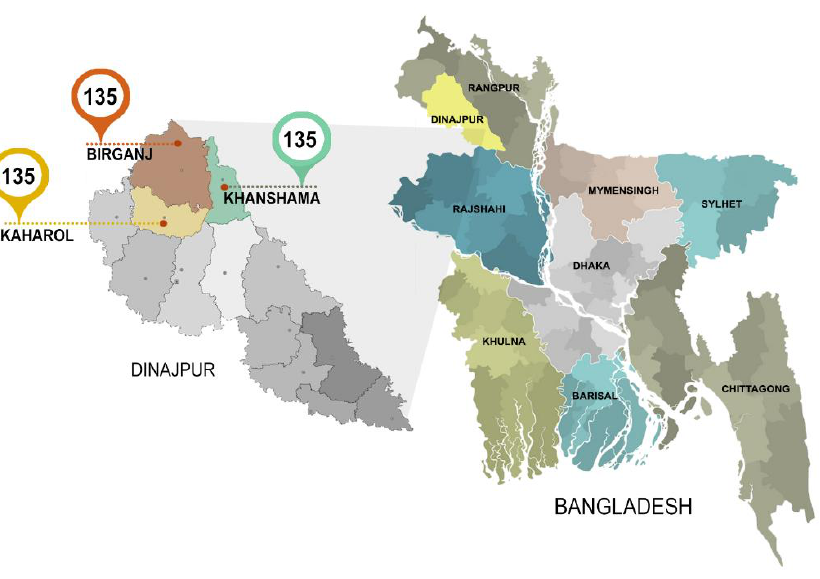
Figure 1. Overview of the study region within Bangladesh and the study areas in Dinajpur district.